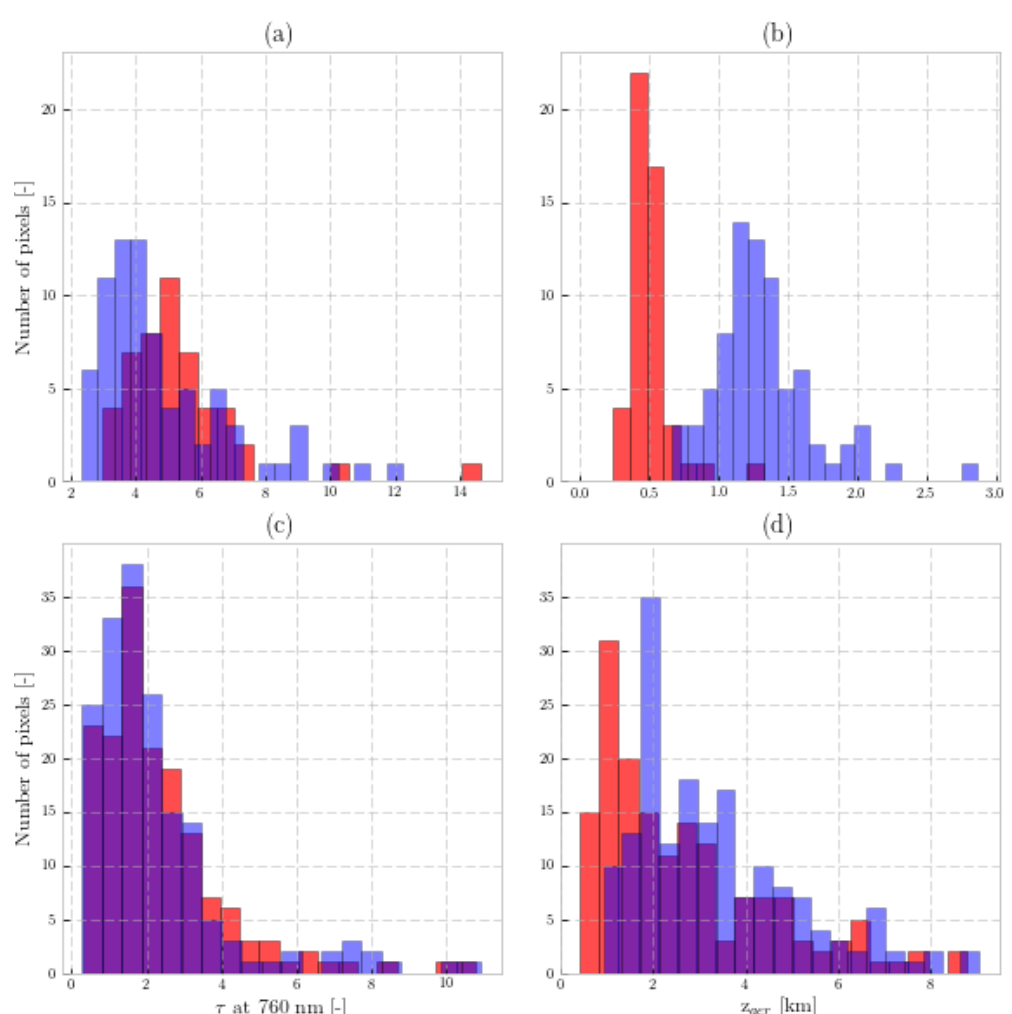
Figure 5. Histograms of fitted aerosol optical thickness ( τ , left column) and aerosol layer height ( z aer , right column) from GOME-2A and GOME-2B pixels. Histograms in red are retrievals from the formal approach and the histograms in blue are results from the dynamic scaling method. (a) Fitted τ from the GOME-2A pixels over the 8 August 2010 wildfire plume over Russian. (b) Retrieved z aer from the GOME-2A pixels over the 8 August 2010 wildfire plume over Russian. (c) Fitted τ from the GOME-2B pixels over the 17 October 2017 wildfire plume over western Europe. (d) Retrieved z aer from the GOME-2B pixels over the 17 October 2017 wildfire plume over western Europe. The axes are adjusted for each